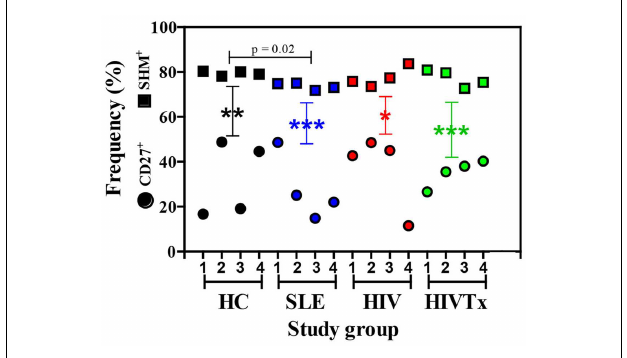
FIGURE 2 | Frequency of SHM + IgM sequences exceeds the frequency of CD27 + IgM B cells in peripheral blood . Frequency of SHM + IgM sequences in HIV and HIVTx (treated) groups was similar to HC (healthy controls), but significantly reduced in individuals with SLE (systemic lupus erythematosus) ( p = 0.02). Frequency of SHM + IgM sequences was significantly greater than the proportion of CD27 + IgM B cells in each group (HC, ** p = 0.001; SLE, *** p < 0.0001; HIV, * p = 0.004; HIVTx, *** p < 0.0001). Reduced frequency of CD27 + IgM B cells in SLE individuals compared to HC failed to reach statistical significance. Frequency of SHM + sequence did not correlate with percent of CD27 + IgM B cells ( r 2 = 0.06, p = 0.35). Symbols: square, IGHM CDRH3 sequences with SHM; circle, CD27 + IgM B